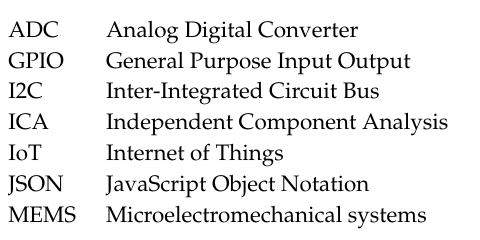
s1, Figure S1: Typical initial action of a duty cycling gas sensor (red line), versus a continuously energized one (black line), Figure S2: Image of one of the ThingSpeak IoT platform